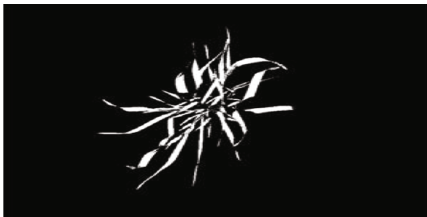
Figure 5: Segmentation algorithm used: Global Automatic Thresholding (Otsu); description: pixel membership loss is there but less than that of the static thresholding method.